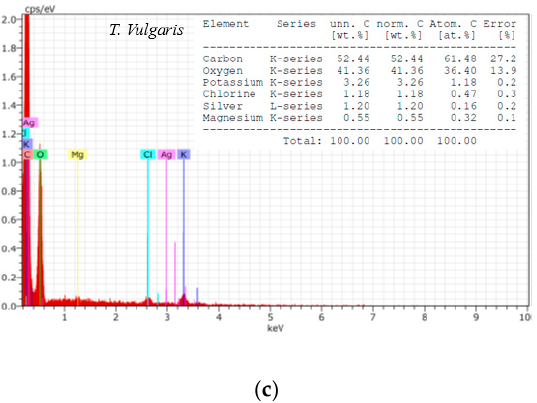
Figure 4. EDS spectra element composition of green synthesized AgNPs using ( a ) A. absinthium, ( b ) H. lupulus, and ( c ) T. vulgaris.